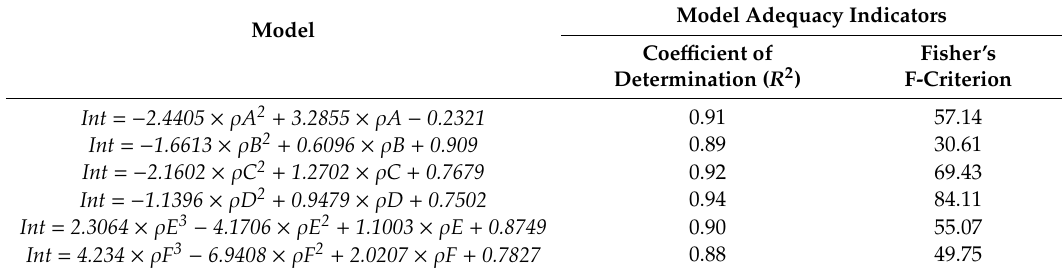
Table 4. Models of the distance-learning structure impact (indicators ρ A– ρ F) on the level students’ integral competency